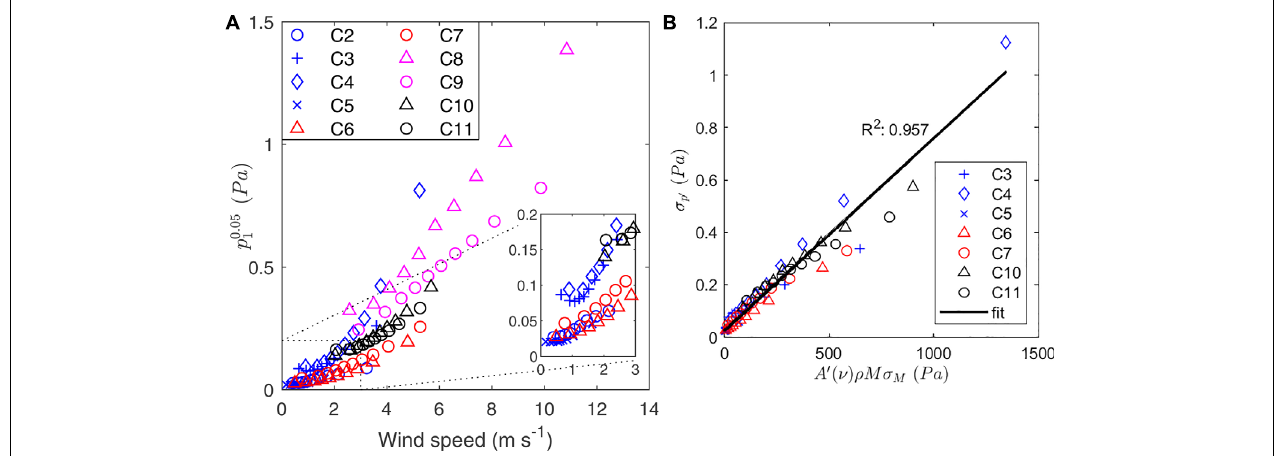
FIGURE 4 | Ranges for ρ 0 . 05 1 pressure fluctuation vs. bin-averaged wind speed for deployments color-coded by site with an inset for wind speeds below 3 m-s - 1 (panel A ). Panel (B) shows a similarity relationship between the standard deviation of perturbation pressure with the product of snow density, wind speed and the standard deviation of wind